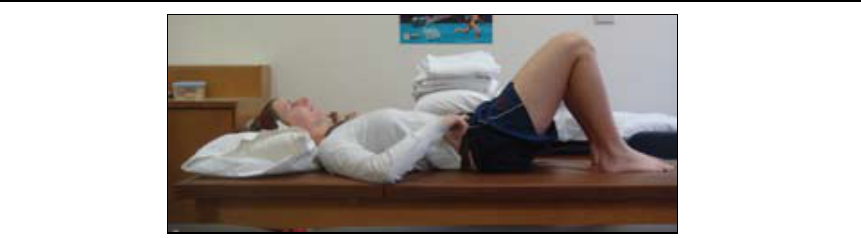
Figure 1: Transverse Abdominal activation. Hold the position and do 8 breaths 10 times (Hodges and Richardson 1996)